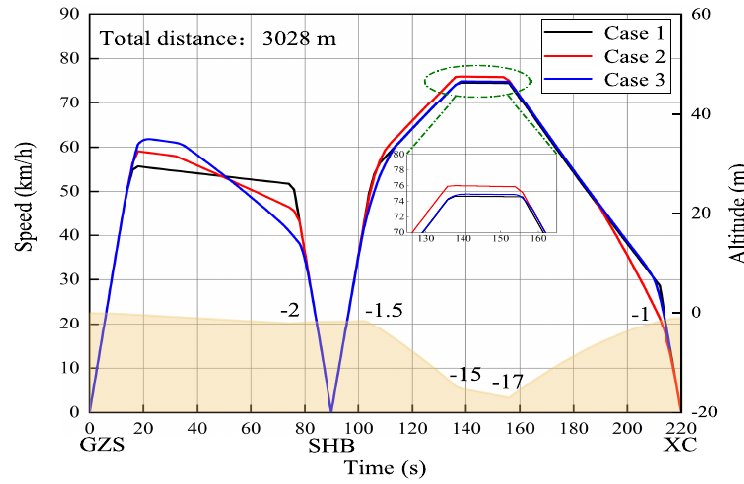
Figure 5. The optimal speed trajectories and altitude profile for cases 1–3.